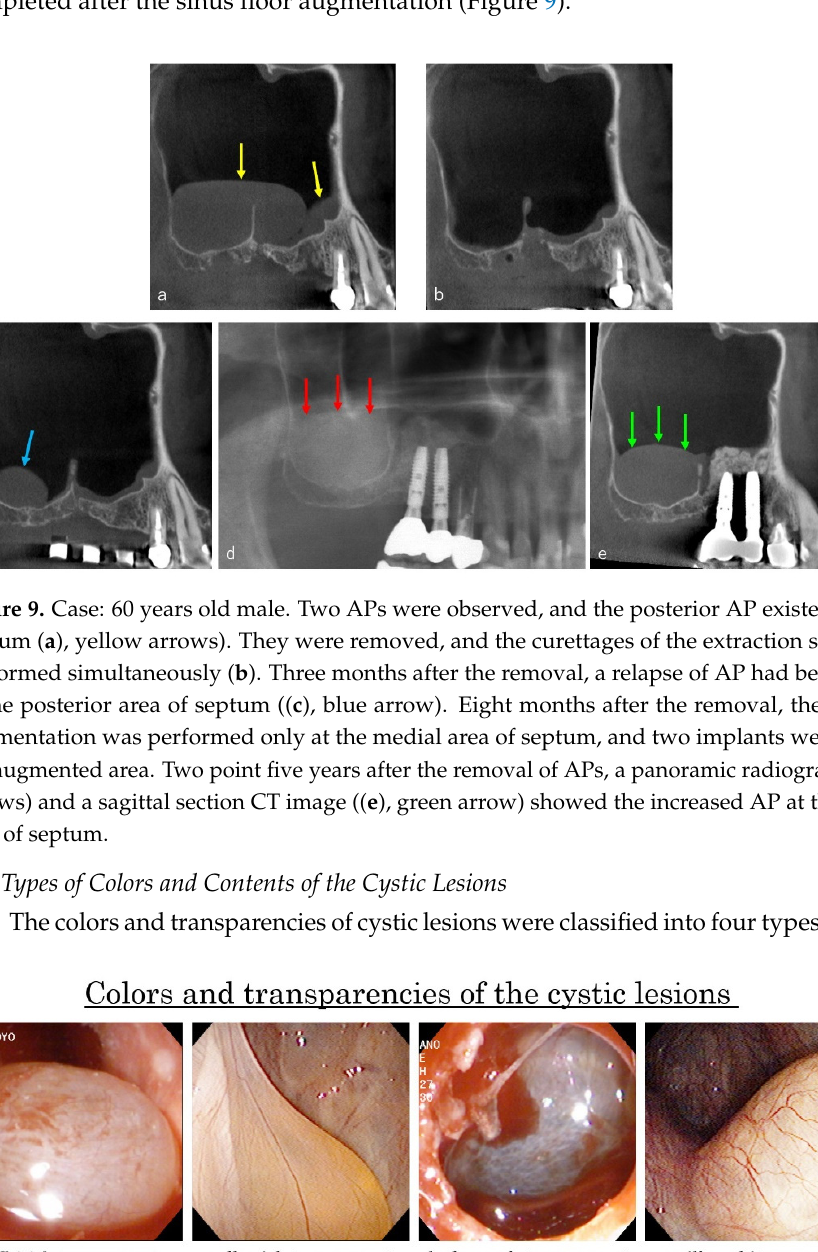
Figure 8. Case: 62 years old female. Two APs were detected on the CBCT before surgery ( a ). The cysts were removed, and the flat shaped faint opacity at the bottom of maxillary sinus was observed on the CBCT taken immediately after the surgery (( b ), blue arrows). One week after the surgery, a post-operative swelling of the sinus membrane was observed (( c ), yellow arrows). The swelling had disappeared three months after the surgery ( d ), and the sinus floor augmentation was performed successfully four months after the removal of Aps ( e ).